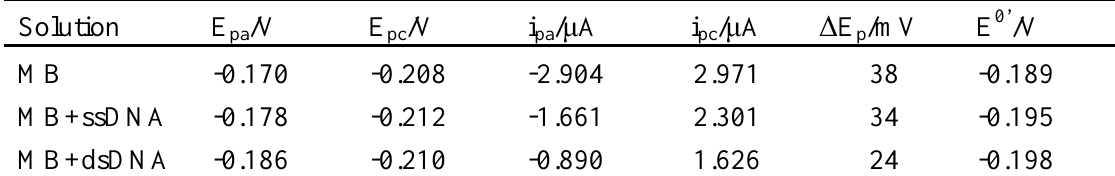
Table 1. Electrochemical data of MB interaction with ssDNA and dsDNA in